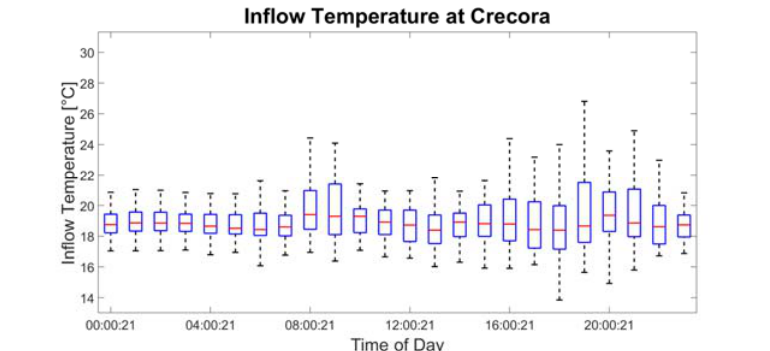
Figure 2. Temperature profile of the wastewater, observed in Ireland, during